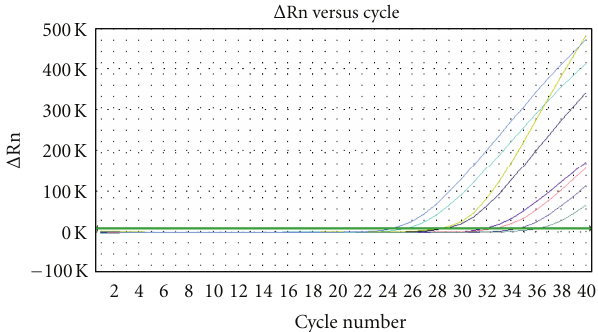
Figure 1: bFGF mRNA expression of human gastric cancer SGC- 7901 cell in 0.1mg/mL, 1 mg/mL N-desulfated heparin groups, and control